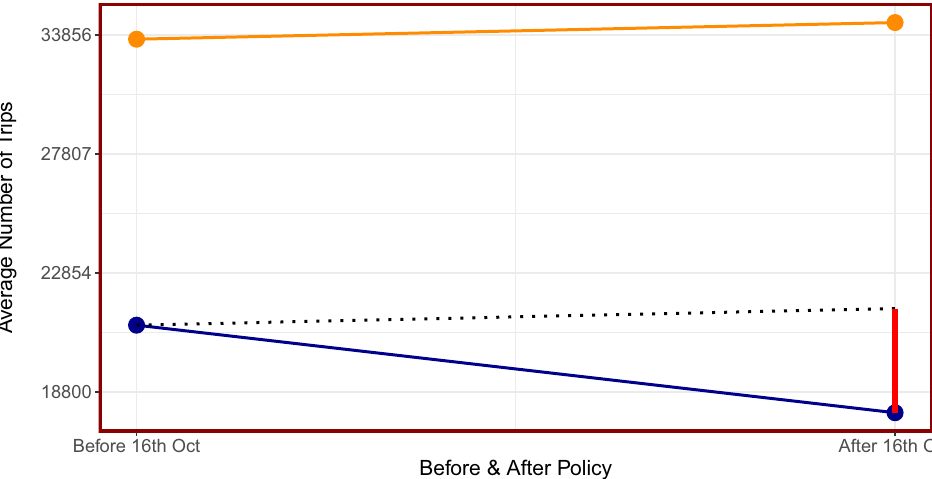
Figure 6. Difference-in-difference results for the incoming data: the 4 points correspond to the average number of trips before and after the policy was implemented, the orange colour corresponds to Madrid and the blue corresponds to Cataluña. The dotted line is Madrid’s line shifted downwards to show how potentially Cataluña’s mobility would have gone had they not implemented the policy. Finally, the vertical red line corresponds to the diff-in-diff regression coefficient as given in Eq. (2). We find the causal effect from the model corresponds to a reduction in mobility of 17.5% when using Madrid as the control group. The y-axis has been re-scaled back to the number of